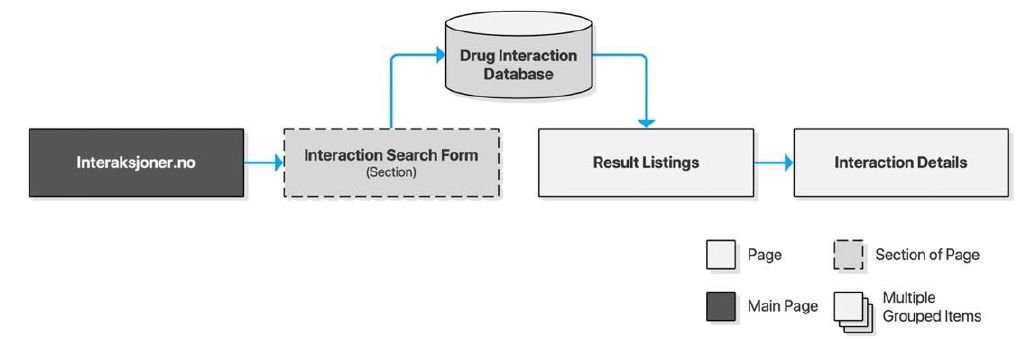
Figure 3. Sitemap for Interaksjoner.no.